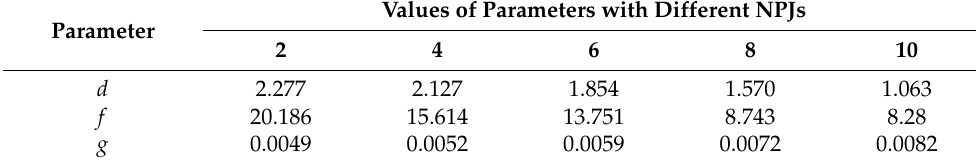
Table 10. Values of parameters d , f , and g. Parameter